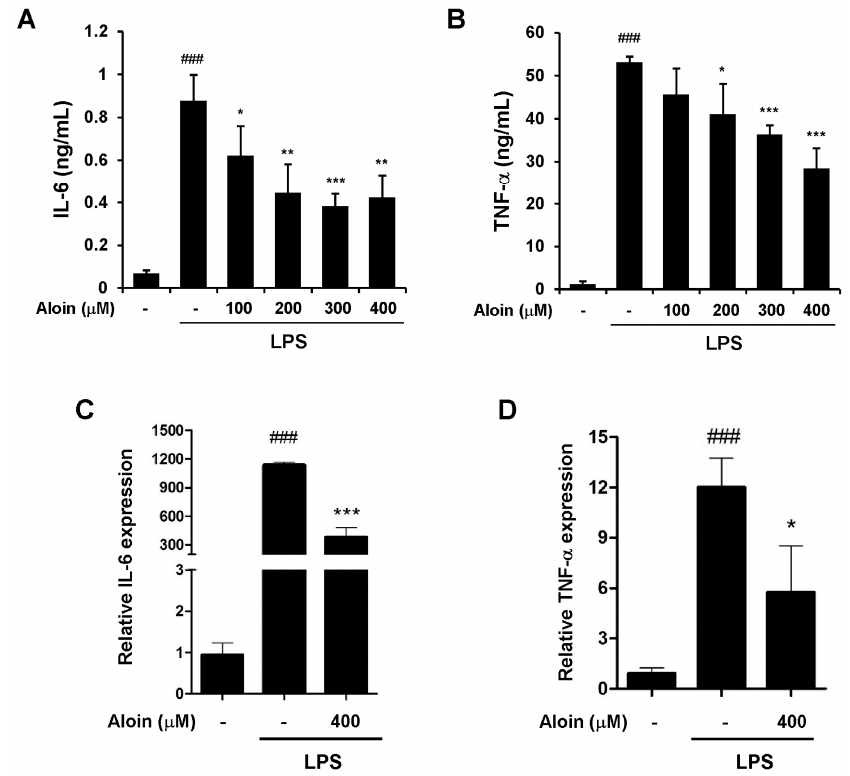
Figure 2. Aloin inhibits the LPS-induced expression of IL-6 and TNF- α RAW 264.7 cells were pre-treated with aloin for 2 h prior to LPS (100 ng/mL) stimulation. Cell-free supernatants were collected to detect ( A ) Interleukin 6 (IL-6) and ( B ) Tumor necrosis factor alpha (TNF- α ) concentrations via ELISA after LPS treatment for 9 h and 24 h, respectively. The mRNA expression levels of ( C ) IL-6 and ( D ) TNF- α were determined by qPCR in RAW 264.7 cells pre-treated with aloin (400 µ M) followed by LPS (100 ng/mL) stimulation for 6 h. The data shown are the means ± SD of three experiments. ### p < 0.001 is significantly different from the control. * p < 0.05, ** p < 0.01, and *** p < 0.001 are different from the LPS alone.